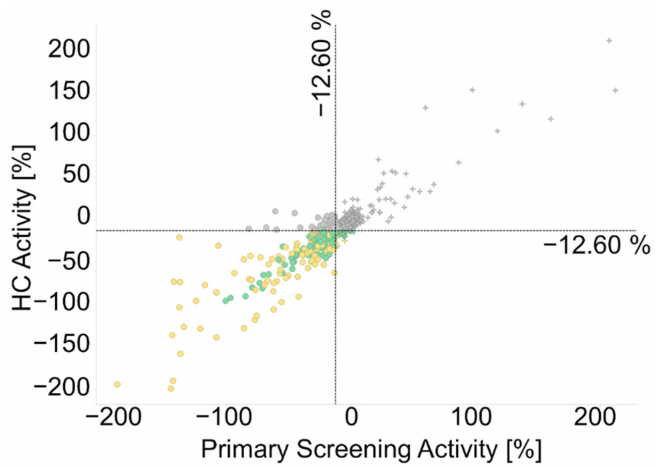
Figure 5. Scatter plot of primary screening versus HC in terms of activity percent. The dots are shaped by outcome of the primary screening: circles and diamonds correspond to actives and inactives, respectively. The dots are colored by outcome of the HC: green, yellow, and grey correspond to active, interfering, and inactive compounds, respectively.